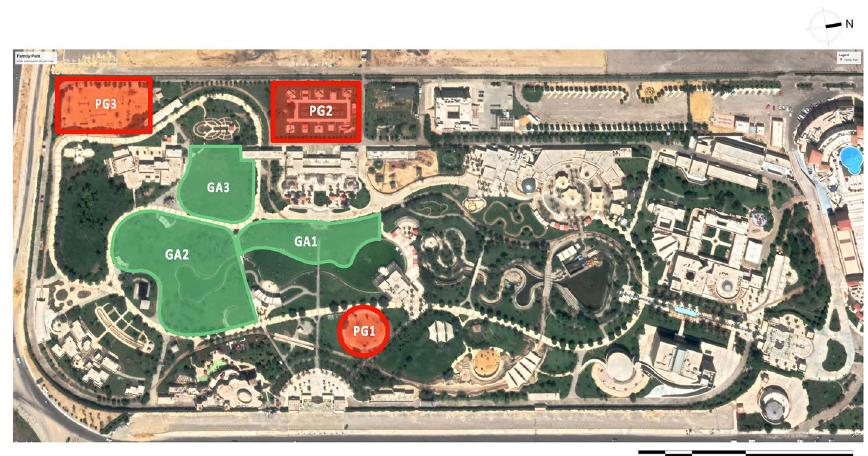
Fig. 1 Green areas and playgrounds selected for the study (Google Earth)